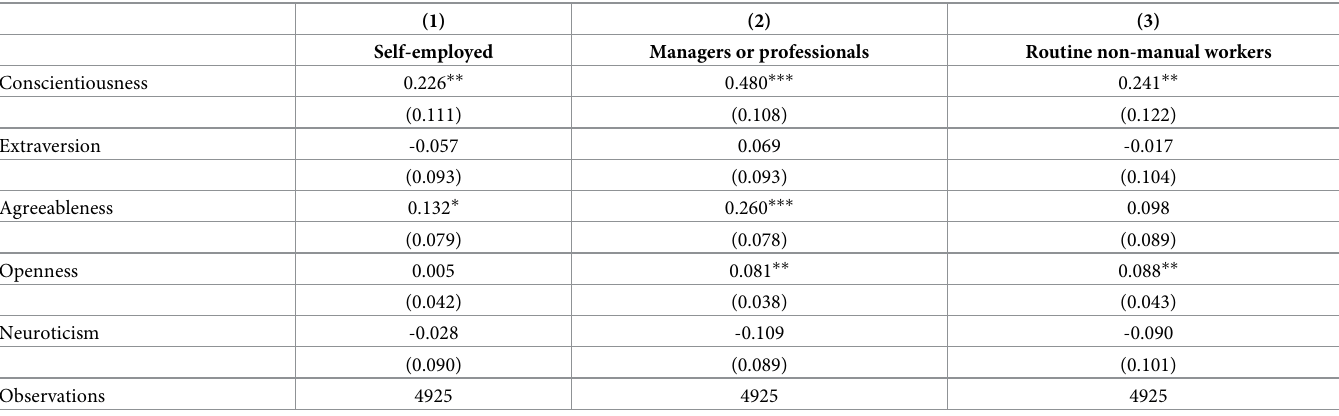
Table 3. Personality traits and occupational types.